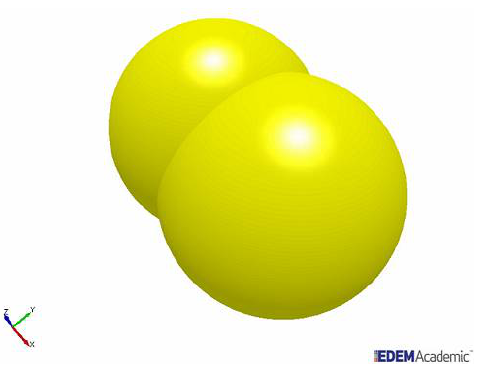
Figure 2. Model particle with an aspect ratio of 0.7 used in the simulations.